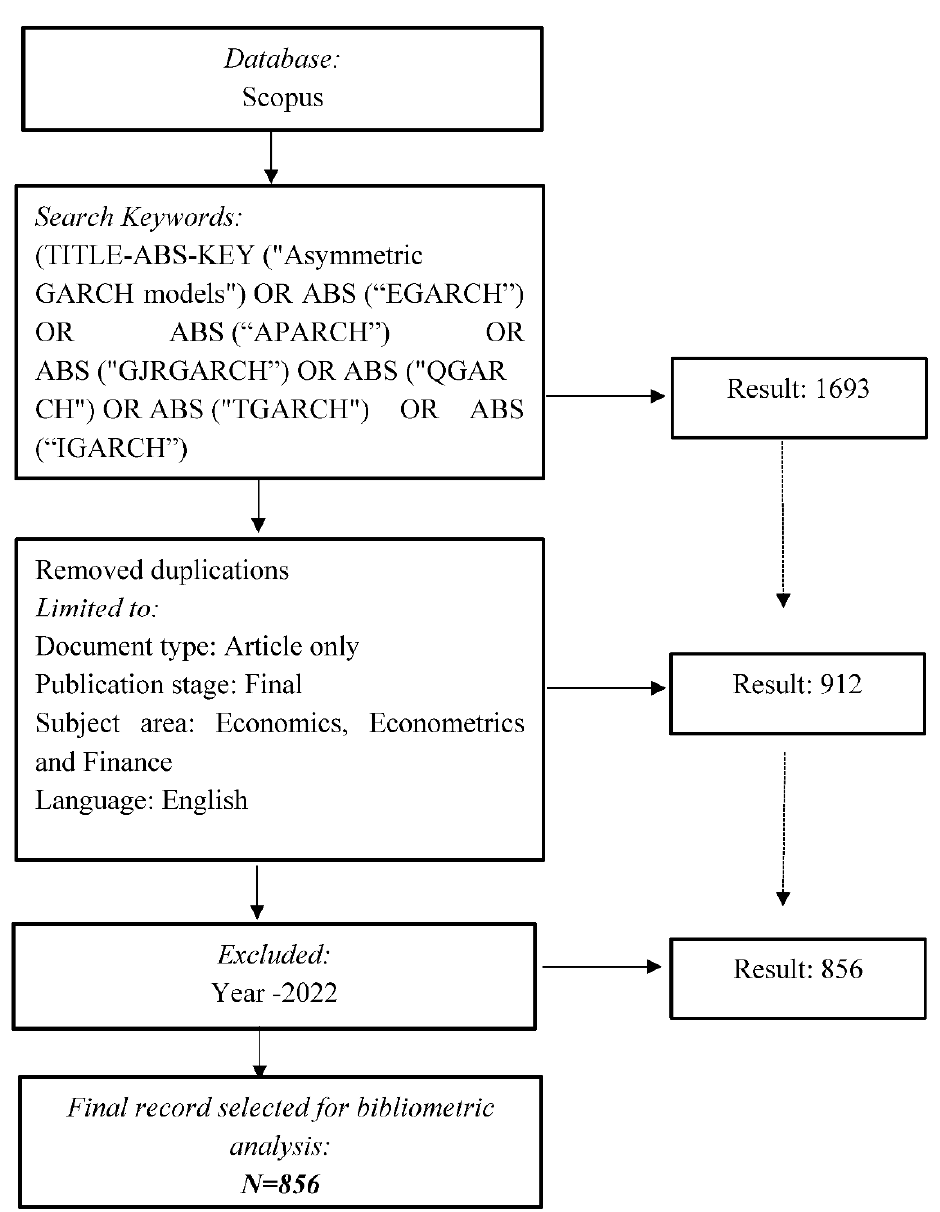
Figure 1. Dataset extraction and processing mechanism for bibliometric analysis.